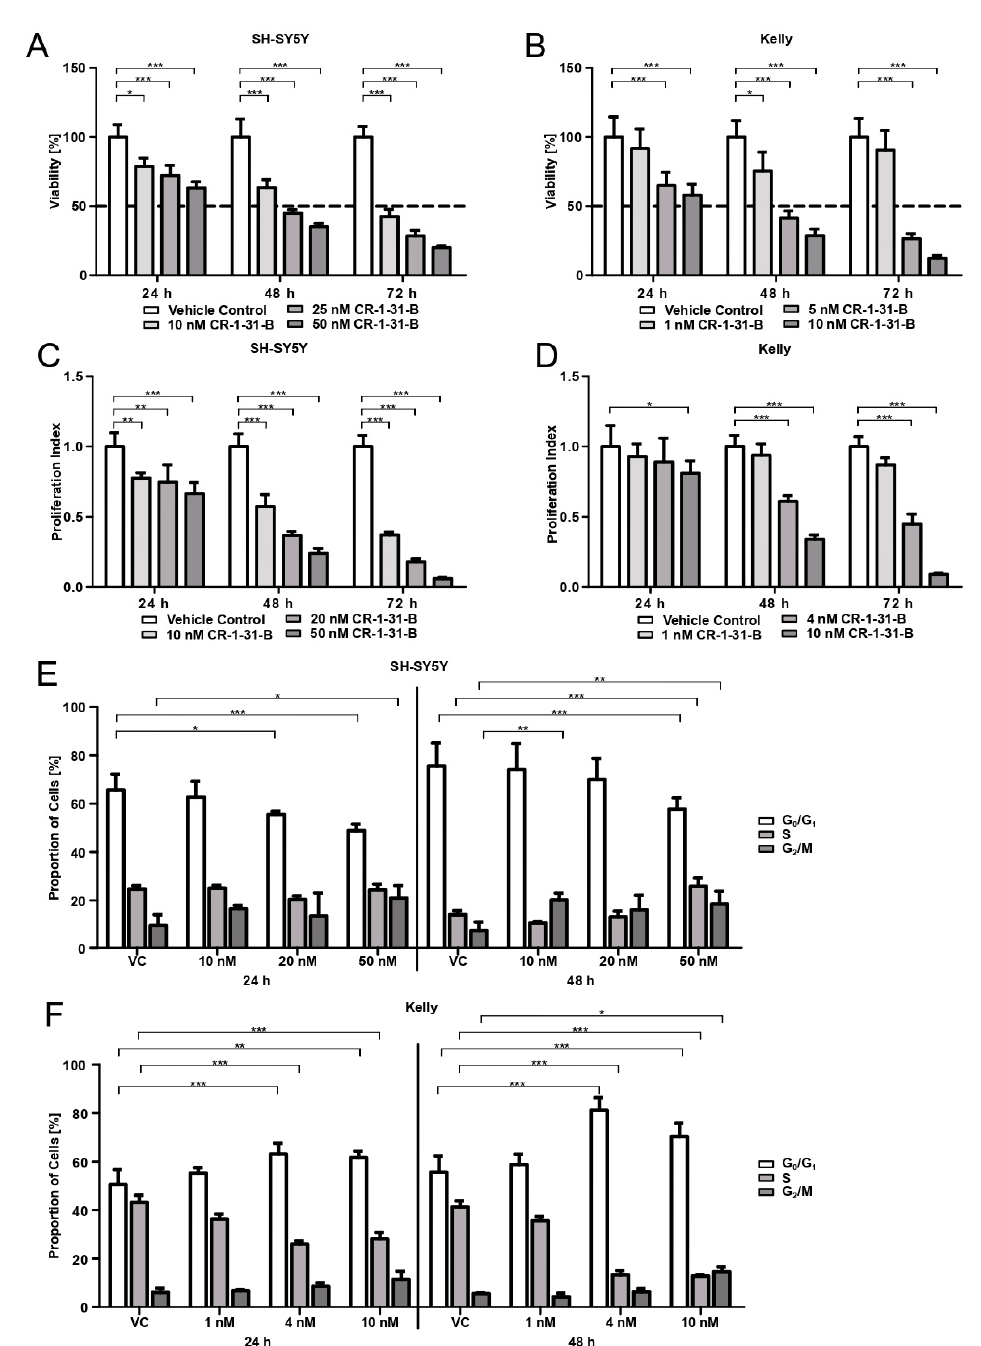
Figure 2. Targeting eIF4AI using rocaglate derivative CR-1-31-B in neuroblastoma cell lines SH-SY5Y and Kelly reduces cell viability and proliferation with cell cycle phase alterations over time. SH-SY5Y cells were treated with 10, 20 (25 nM for viability), and 50 nM and Kelly cells with 1, 5, and 10 nM CR-1-31-B over 24, 48, and 72 h. As a vehicle control, 0.5% (v/v) DMSO was used (VC). A and B show data of the viability changes upon CR-1-31-B treatment using MTT assay of SH-SY5Y cells ( A ) and Kelly cells ( B ), represented as the percentage of viable cells normalized to VC. C and D show alterations in the proliferation index upon CR-1-31-B treatment using BrdU assay in SH-SY5Y cells ( C ) and Kelly cells ( D ) normalized to VC. Determination of cell cycle phases of SH-SY5Y cells ( E ) and Kelly cells ( F ) upon CR-1-31-B treatment was measured by flow cytometry. Depicted are percentages of cells in the G0/G1 phase (white bars), S-phase (light grey bars), and G2/M-phase (dark grey bars). Two-way analysis of variance with Bonferroni post-hoc-test was used for statistical analysis for all tests, bars represent mean ± SEM, * p < 0.05, ** p < 0.01, *** p < 0.001, three independent experiments were performed for MTT and BrdU assay, cell cycle was evaluated in four independent experiments.